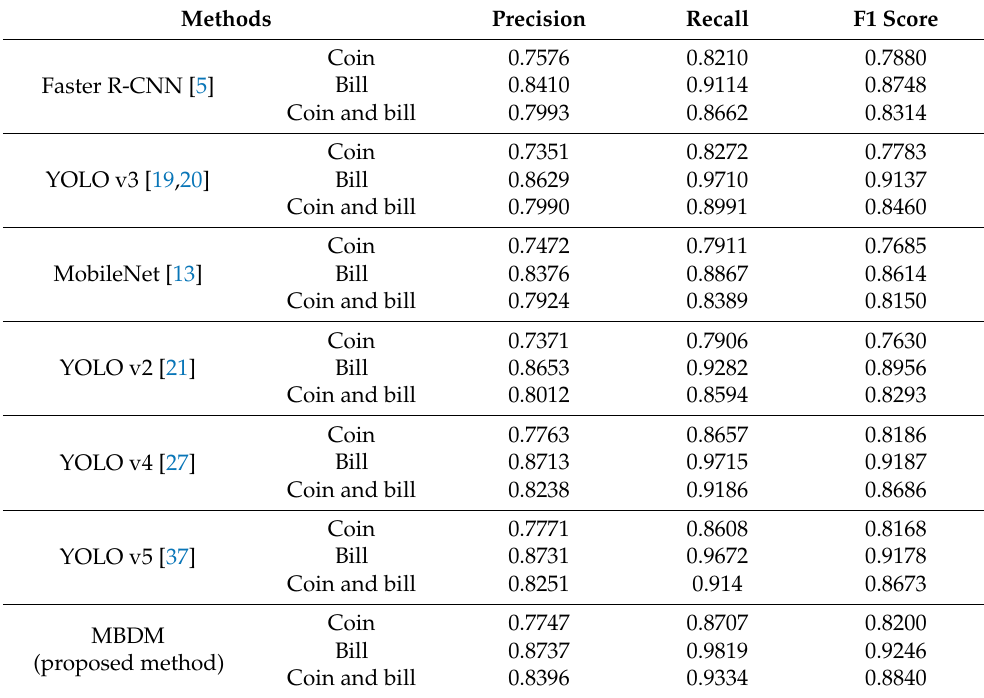
multinational banknote database.